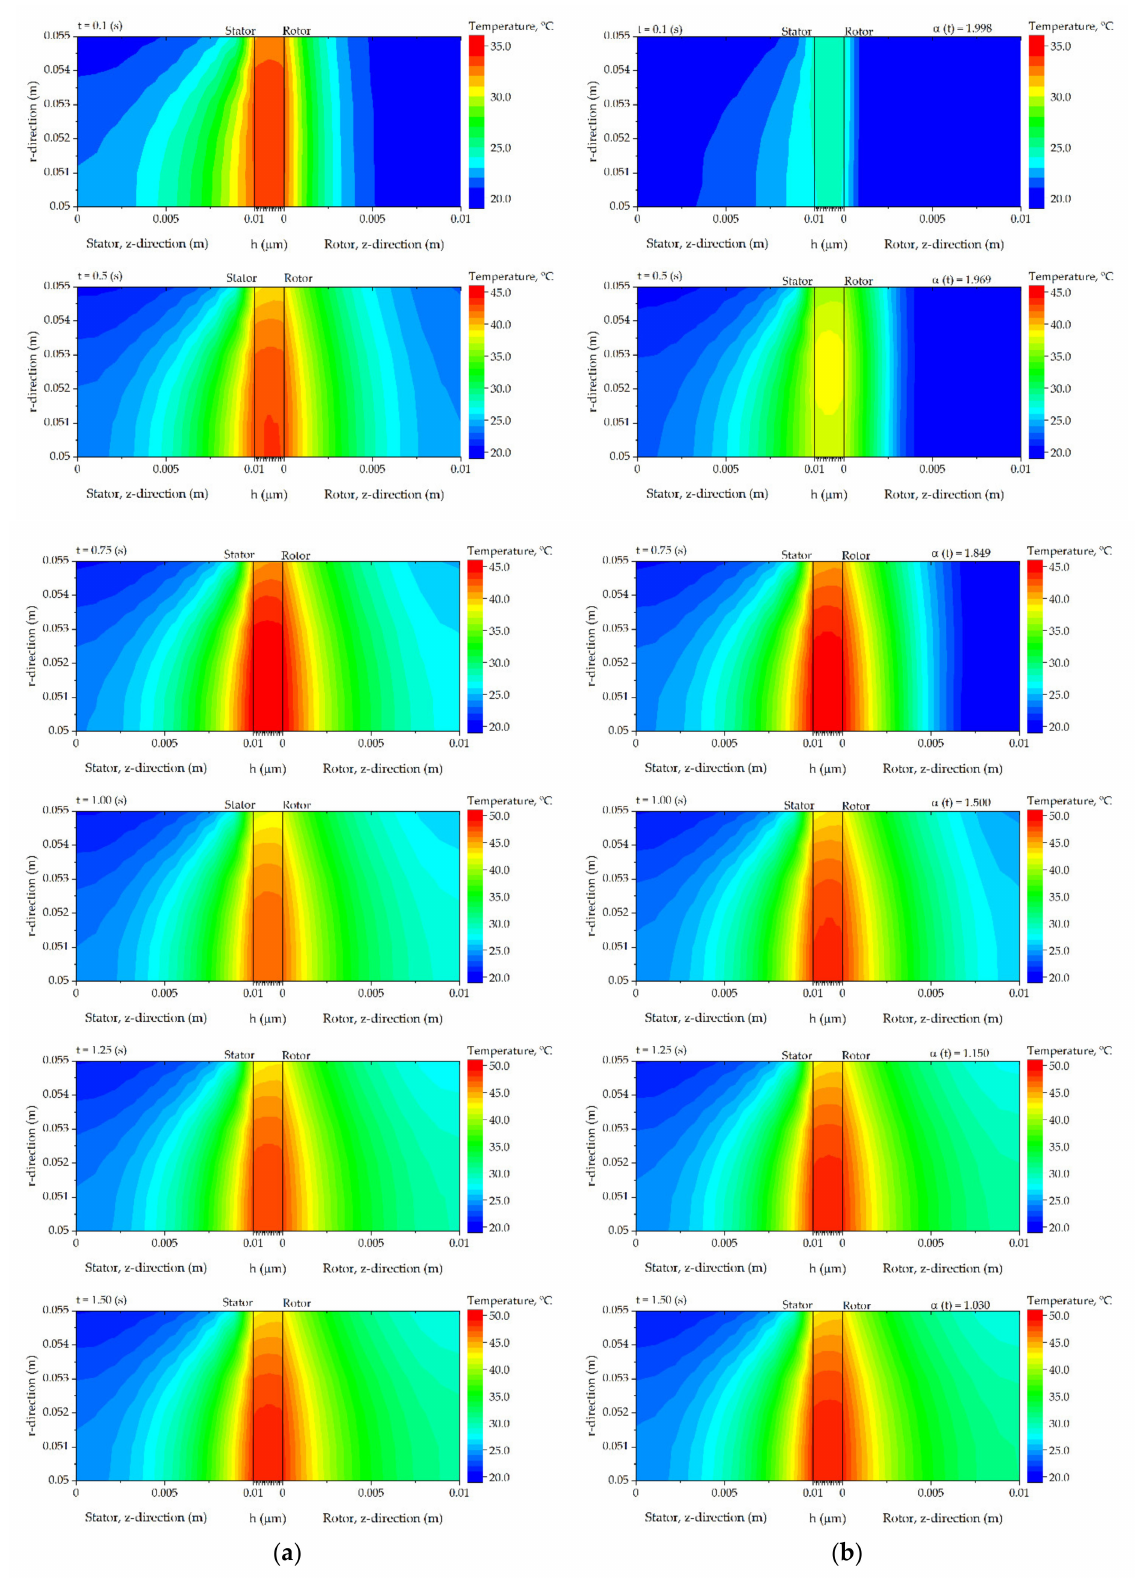
Figure 4. Distribution of temperature in the cross-section of the non-contacting face seal at different values of α . ( a ) for α = 1, ( b ) for α ( t ) =